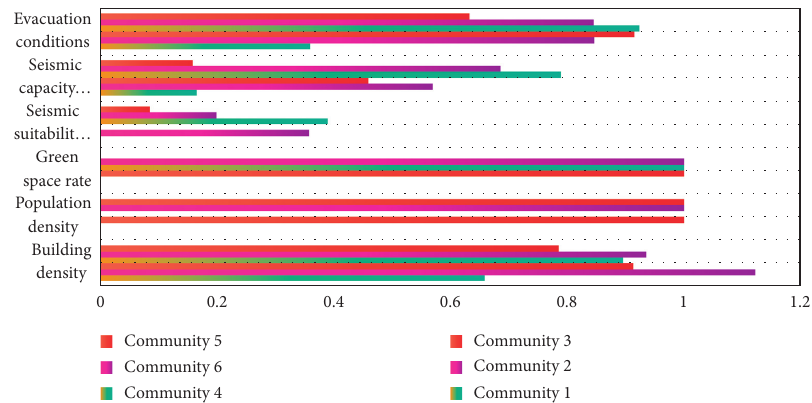
Figure 1: The value of six evaluation indexes in six communities. Table 1: Bearing capacity of frame joints.